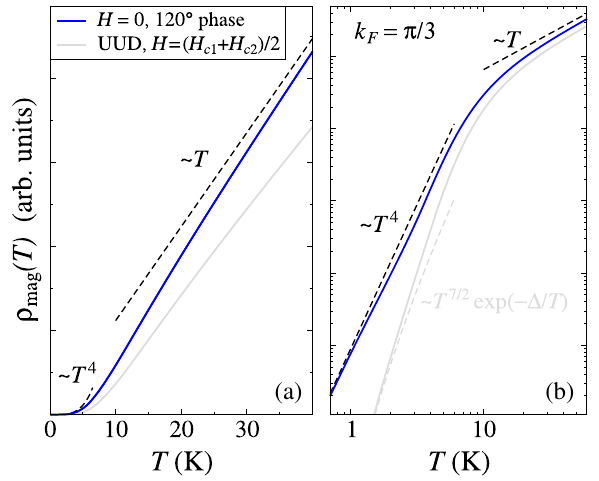
FIG. 9. The T dependence of ρ due to magnetic scattering mag (37) on the (a) linear and (b) log-log scale in the 120° state, H ¼ 0 , and in the middle of the UUD phase, H ¼ ð H c 2 þ H c 1 Þ = 2 , for the parameters from Table I and k F ¼ π = 3 . Dashed lines are Bloch-Grüneisen ’ s law, T 4 in 2D, Ohm ’ s law, T , and exponential asymptotics, see